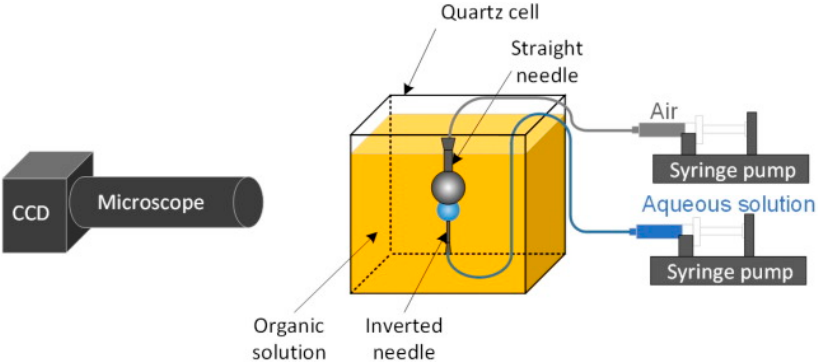
Figure 5. The setup using a bubble and a droplet as probes to analyze the mass transfer process. Reprinted with permission from Ref. [108]. 2023, Elsevier.